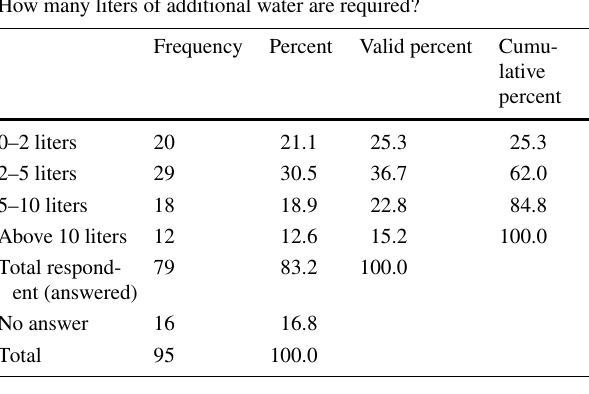
Fig. 7 Additional water required in percentage after the